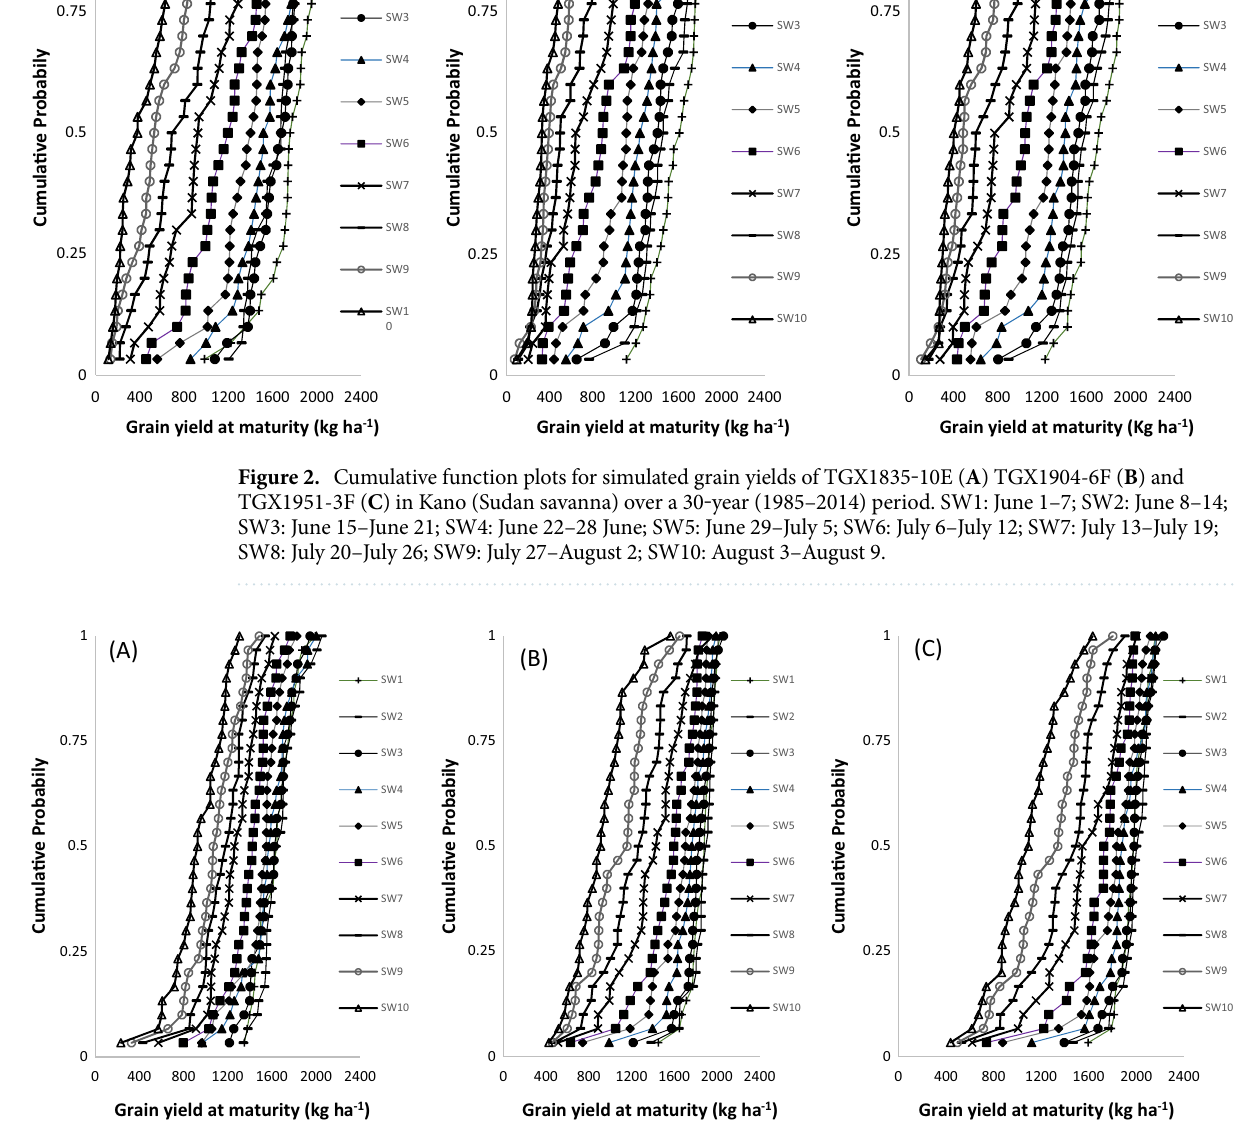
Grain yield at maturity (kg ha -1 ) Figure 3. Cumulative function plots for simulated grain yields of TGX1835 ‐ 10E ( A ) TGX1904-6F ( B ) and TGX1951-3F ( C ) in Zaria (northern Guinea savanna) over a 30 ‐ year (1985–2014) period. SW1: June 1–7; SW2: June 8–14; SW3: June 15–June 21; SW4: June 22–28 June; SW5: June 29–July 5; SW6: July 6–July 12; SW7: July 13–July 19; SW8: July 20–July 26; SW9: July 27–August 2; SW10: August 3–August to 1384 kg ha −1 for TGX1835-10E, 931–1447 kg ha −1 for TGX1904-6F and 1060–1531 kg ha −1 for TGX1951-3F. Averaged simulated grain yield decrease with delay in sowing with highest yield simulated for SW1 and lowest yield for SW10 for all the tested varieties. The results show that the most suitable sowing windows for TGX1835- 10E, TGX1904-6F, and TGX1951-3F were SW1–SW5, SW1–SW8 and SW1–SW9 beyond which yields will decline by 8–32%, 10–19%, and 10% for TGX1835-10E, TGX1904-6F, and TGX1951-3F, respectively. Cumulative probability distributions (CPD) showing the simulated soybean grain yield of TGX1835 ‐ 10E, TGX1904-6F and TGX1951-3F within each site are presented in Figs. 2, 3, 4. In Kano in the SS agro-ecology the CPD shows that each delay in sowing progressively decreases yield of soybean. For variety TGX1835 ‐ 10E, sowing between SW1–SW5 resulted in grain yields of above 1200 kg ha −1 (range 1210–1639 kg ha −1 ) in 75% of the simulated years while delaying sowing produced yields < 1000 kg ha −1 with the lowest yields (< 500 kg ha −1 ) simulated in the late July and August sowings at 75% probability (Fig. 2A). For the medium variety TGX1904- 6F, yields above 1200 kg ha −1 (range 1229–1440 kg ha −1 ) were simulated in 75% of the years when sowing